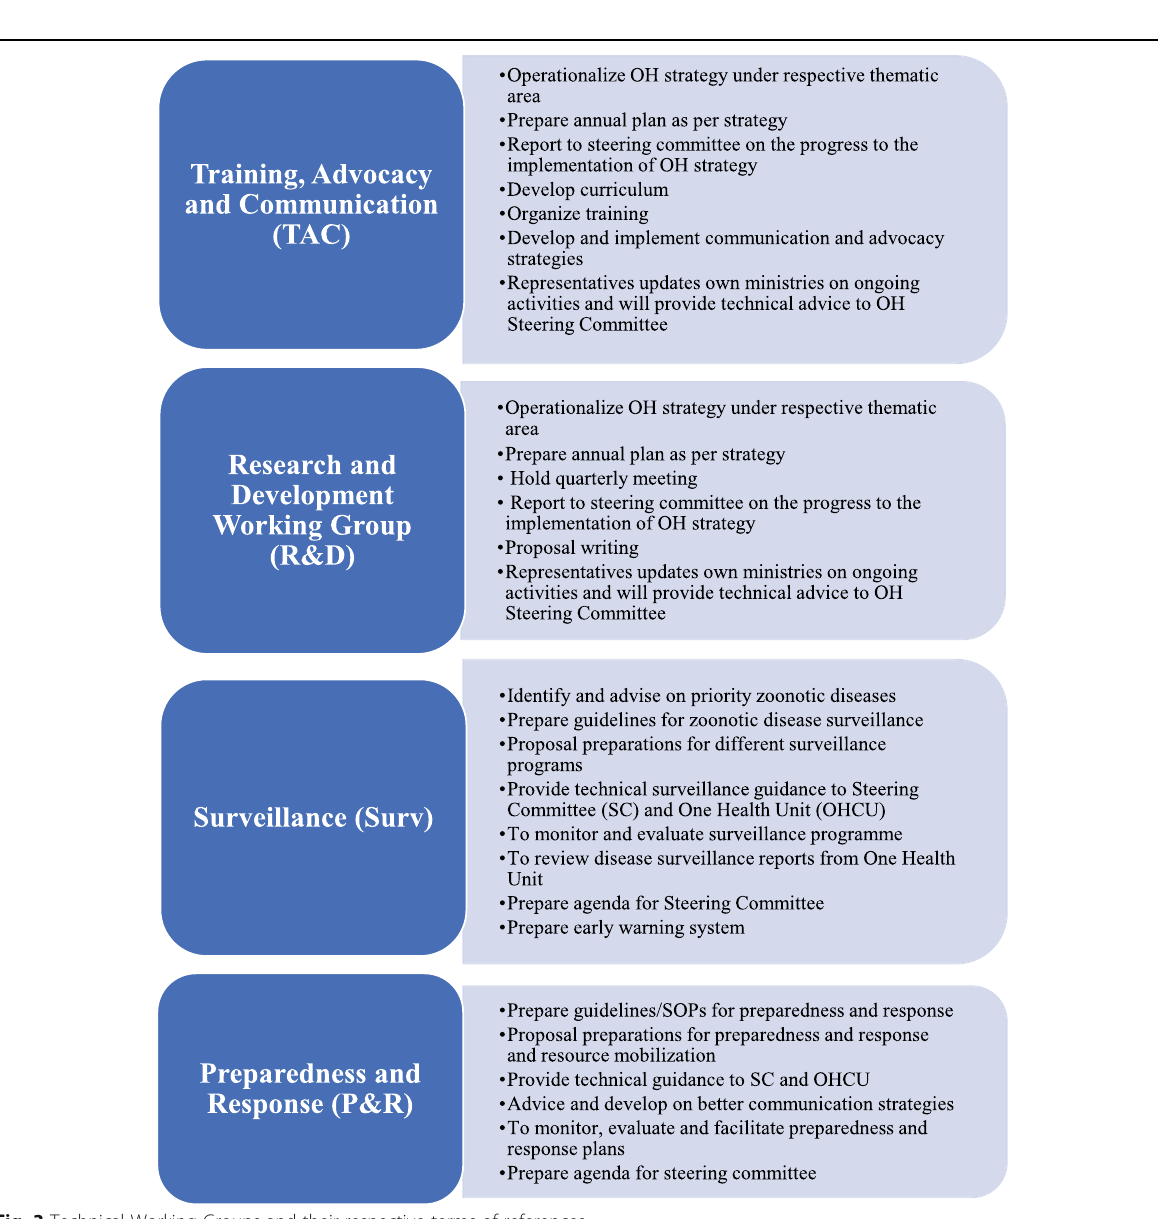
Fig. 3 Technical Working Groups and their respective terms of